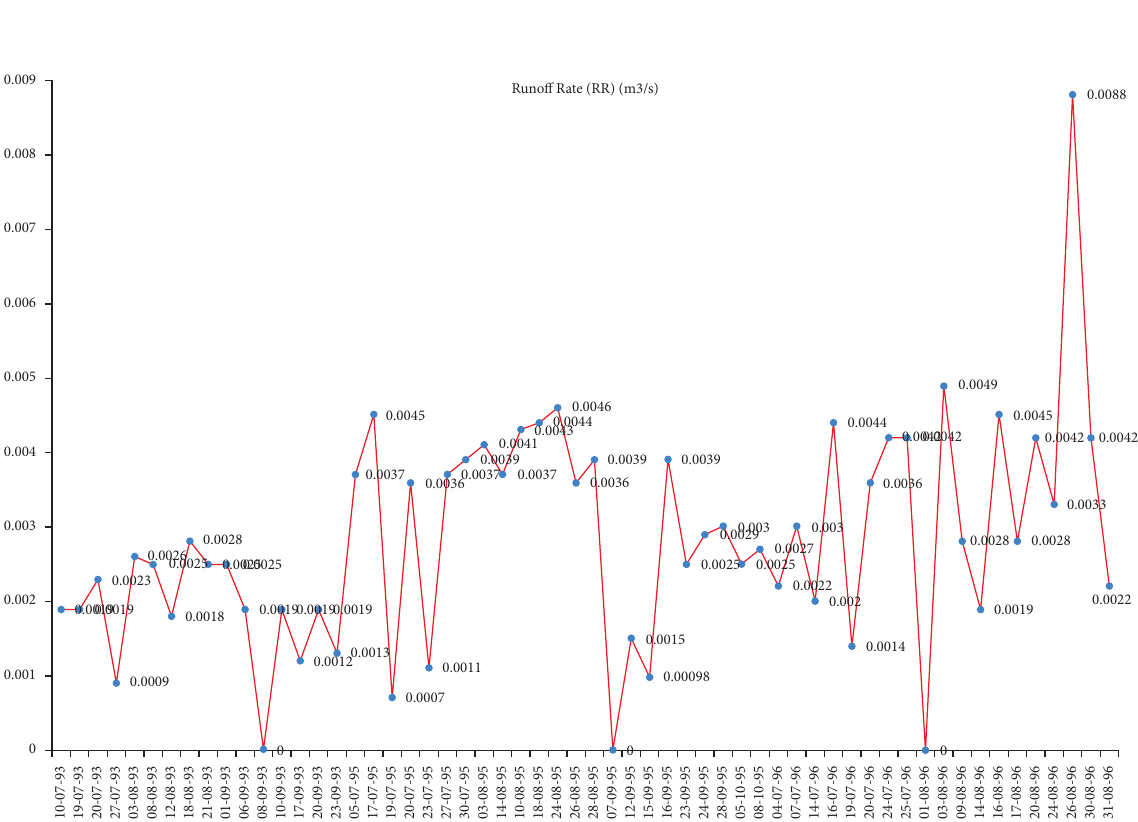
Figure 10: Observed runoff rate with the selected dates of